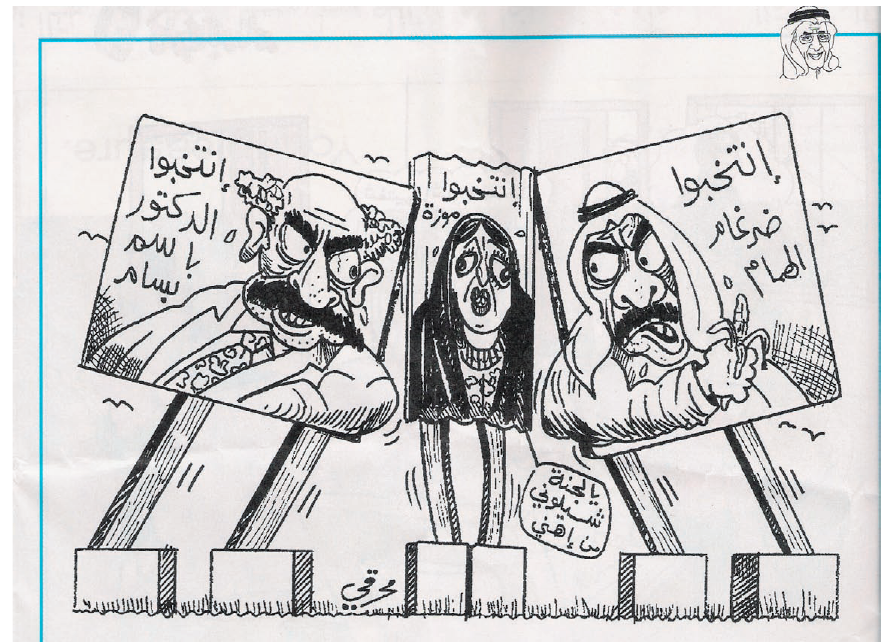
Source : Akhbar Al Khaleej , 24 October